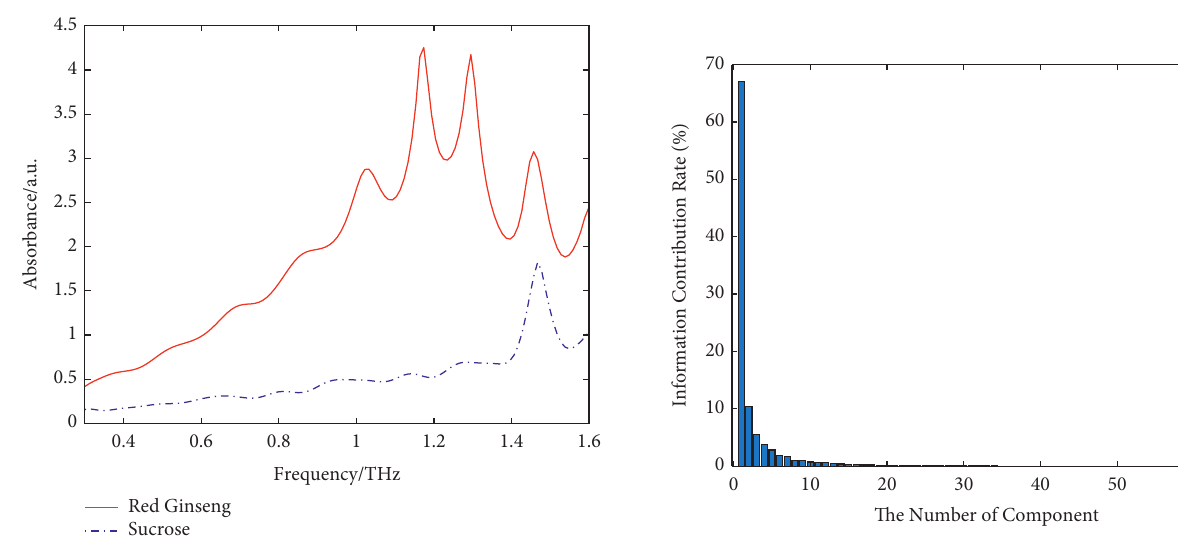
Figure 4: The average absorption spectra of red ginseng and su- crose mixed in different ratios.